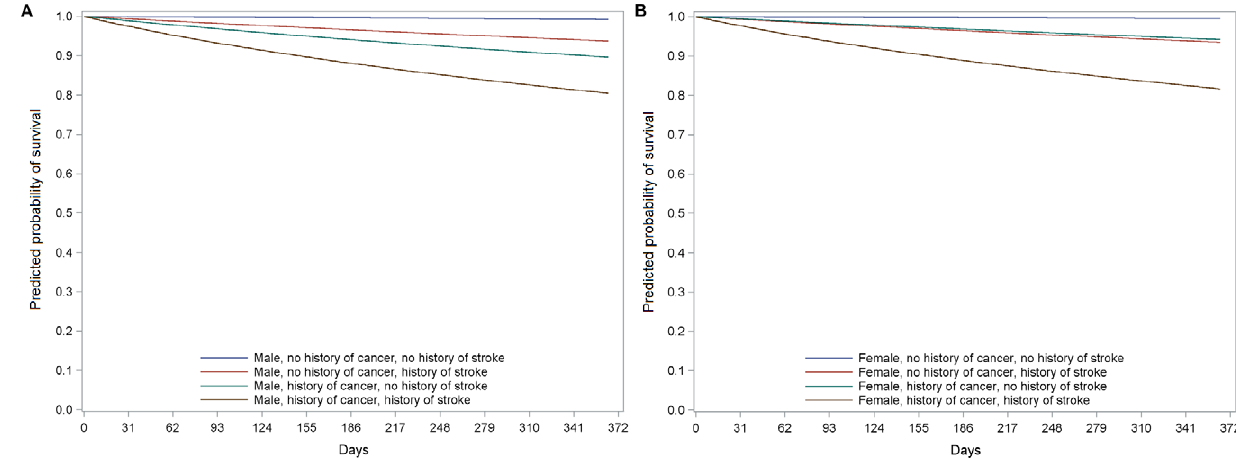
Figure 3. Survival curves for males (a) and females (b) by history of cancer and stroke status during the first year of follow-up.